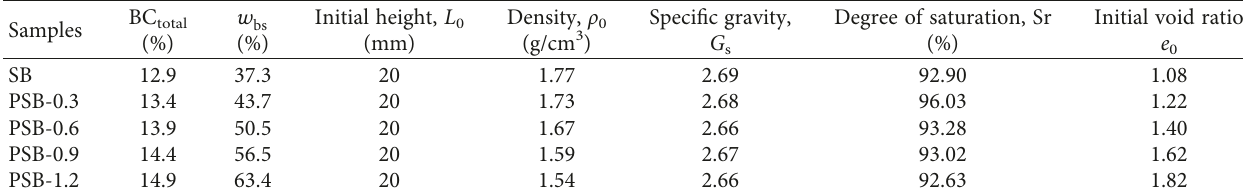
Table 5: The initial index properties of backfills before modified filter press